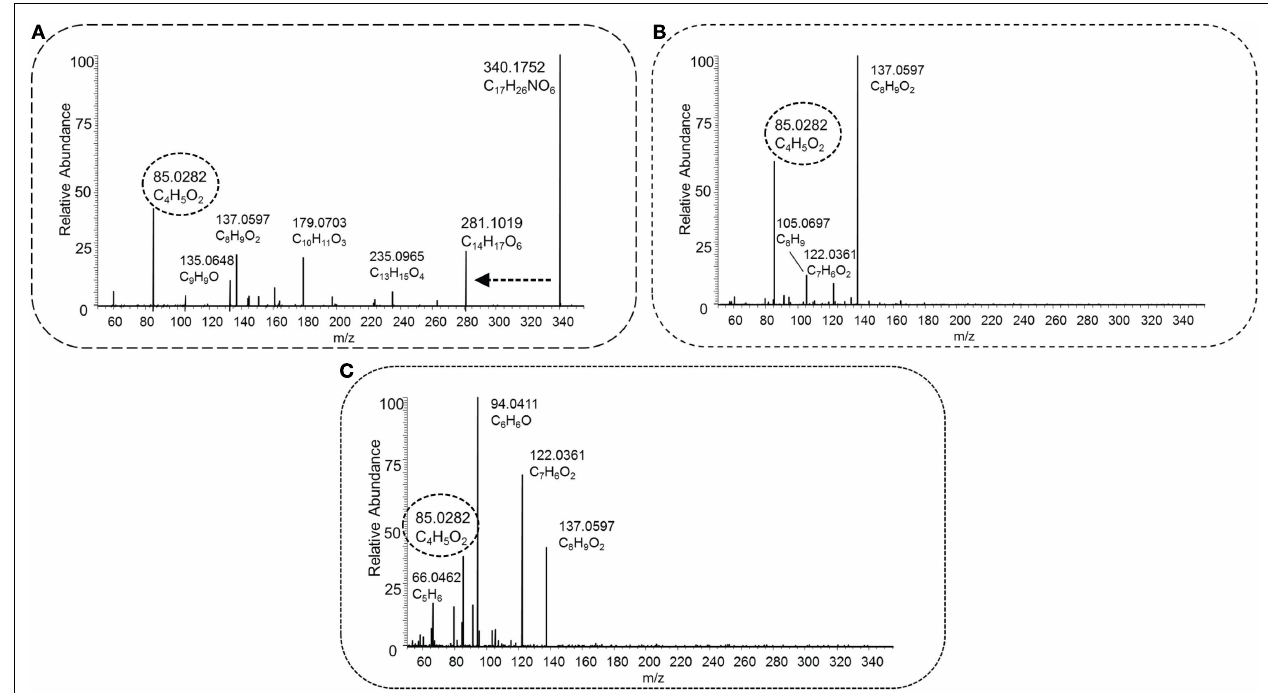
FIGURE 8 | HCD type MS 2 fragmentation spectra obtained at low [30 NCE, (A)], middle [70 NCE, (B)], and high [110 NCE, (C)] energy for precursor mass 340.1755 m / z , with the proposed elemental formula of